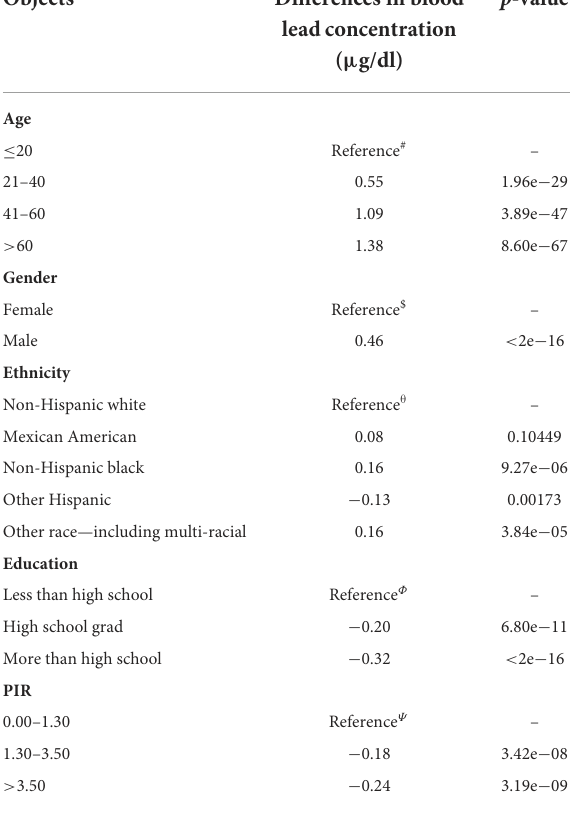
TABLE 2 Differences of blood lead concentration in different subgroups by adjusting demographic